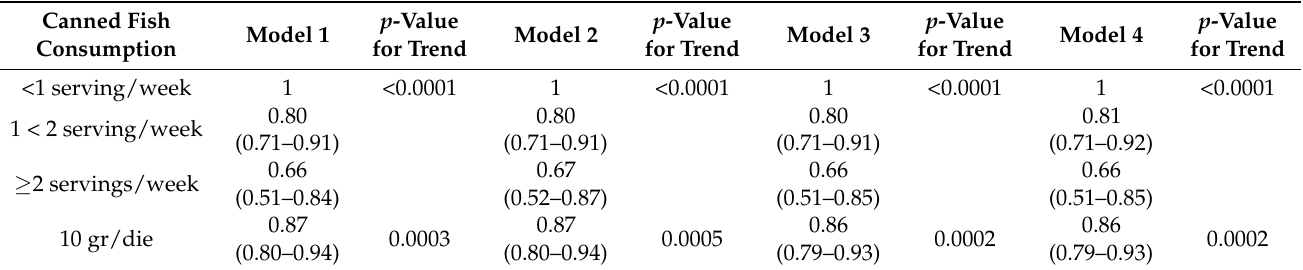
Table 2. Adjusted odds ratios (ORs) and 95% confidence intervals (CIs) of colorectal cancer according to frequency of canned fish